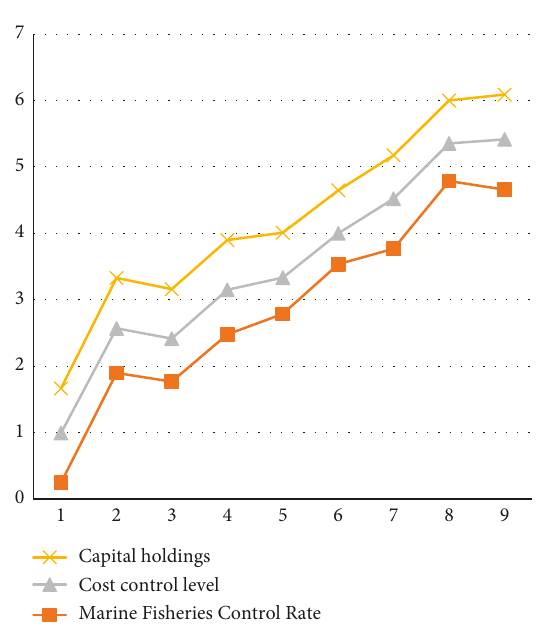
Figure 3: Relation between the cost bias coefficient and total